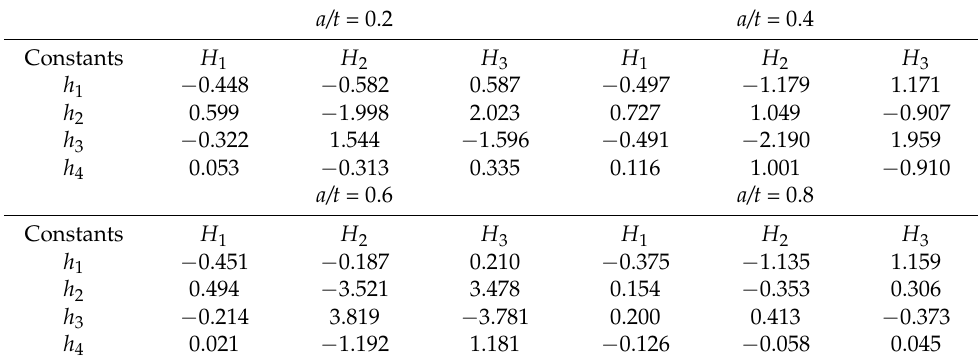
Table 4. The sub-curve fitting constants in Equation (14) h i